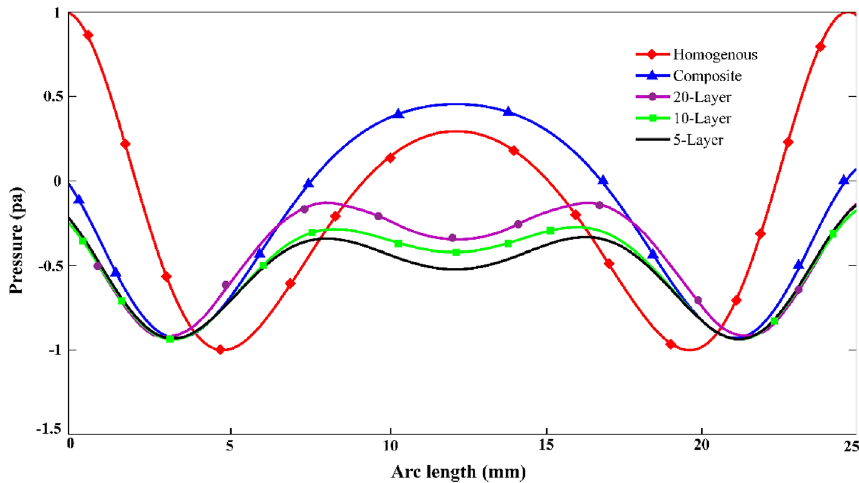
Figure 9. The background pressure field curve calculated along the boundary of cloaking structure for homogenous, composite, multi layer’s